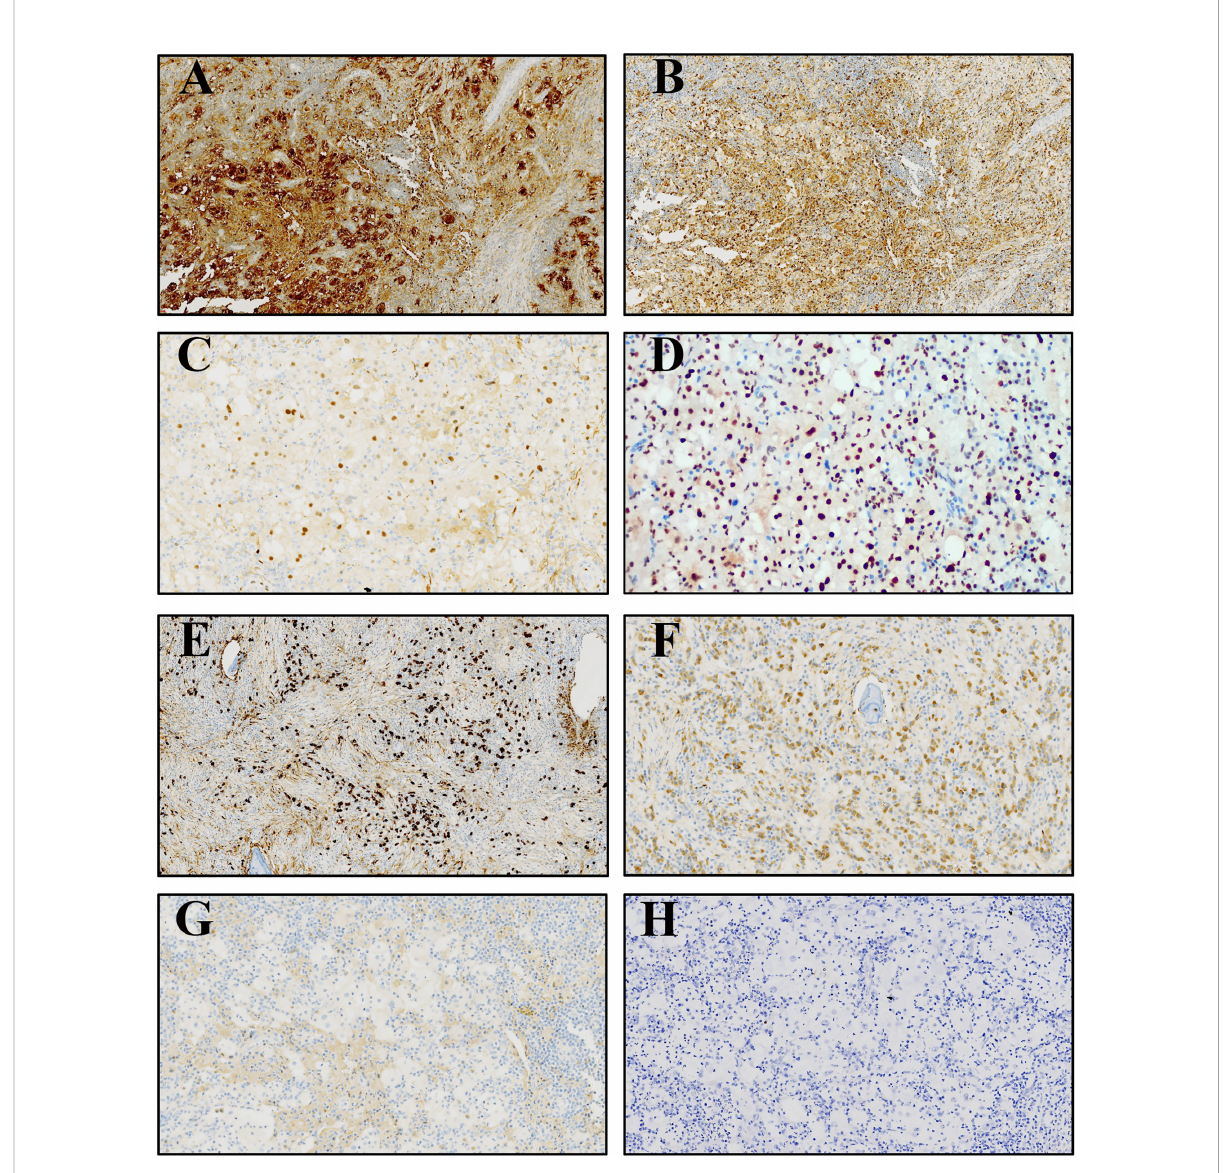
FIGURE 3 Immunophenotype of primary intraosseous RDD. (A, B) The large histiocytes were strongly positive for S100 and CD68, respectively. (C) The nuclear immunoreactivity for cyclin D1 was observed. (D) All cases were positive for OCT2. (E, F) The biopsy specimens of patient 1# had a large quantity of IgG4-positive and IgG-positive plasma cells. (G, H) Langerin and EBER were